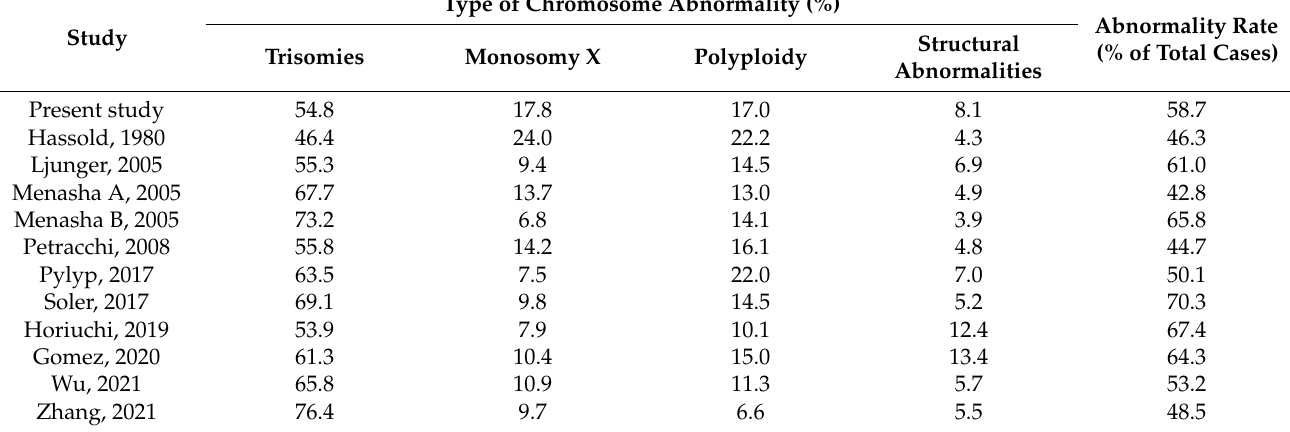
Table 5. Relative frequency of chromosome abnormality types in different studies (all data adjusted to the terms of the present study, rounded